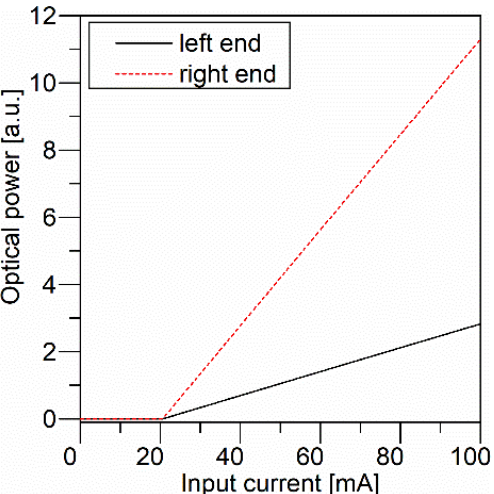
Figure 9. The simulated changing of optical power versus the injection current in the range of 0 to 100 mA with 0.1 mA accuracy. The amplitude-frequency characteristic was simulated using the circuit shown in Figure 5. For comparing and analyzing the stability of the circuit with and without compen- sation, capacitor C5 was first removed and then added. As could be seen in Figure 10, the obtained curves of Aol and β 1 cross each other with a slope of 40 dB/Decade. According to Equation (2), self-oscillation will occur around the frequency where the curves intersect. Although it is unclear whether the zero point on the curve of β 1 originates from the parasitic capacitance of the transistor T1, it does not affect the stability analysis of the circuit and the formulation of a compensation strategy.